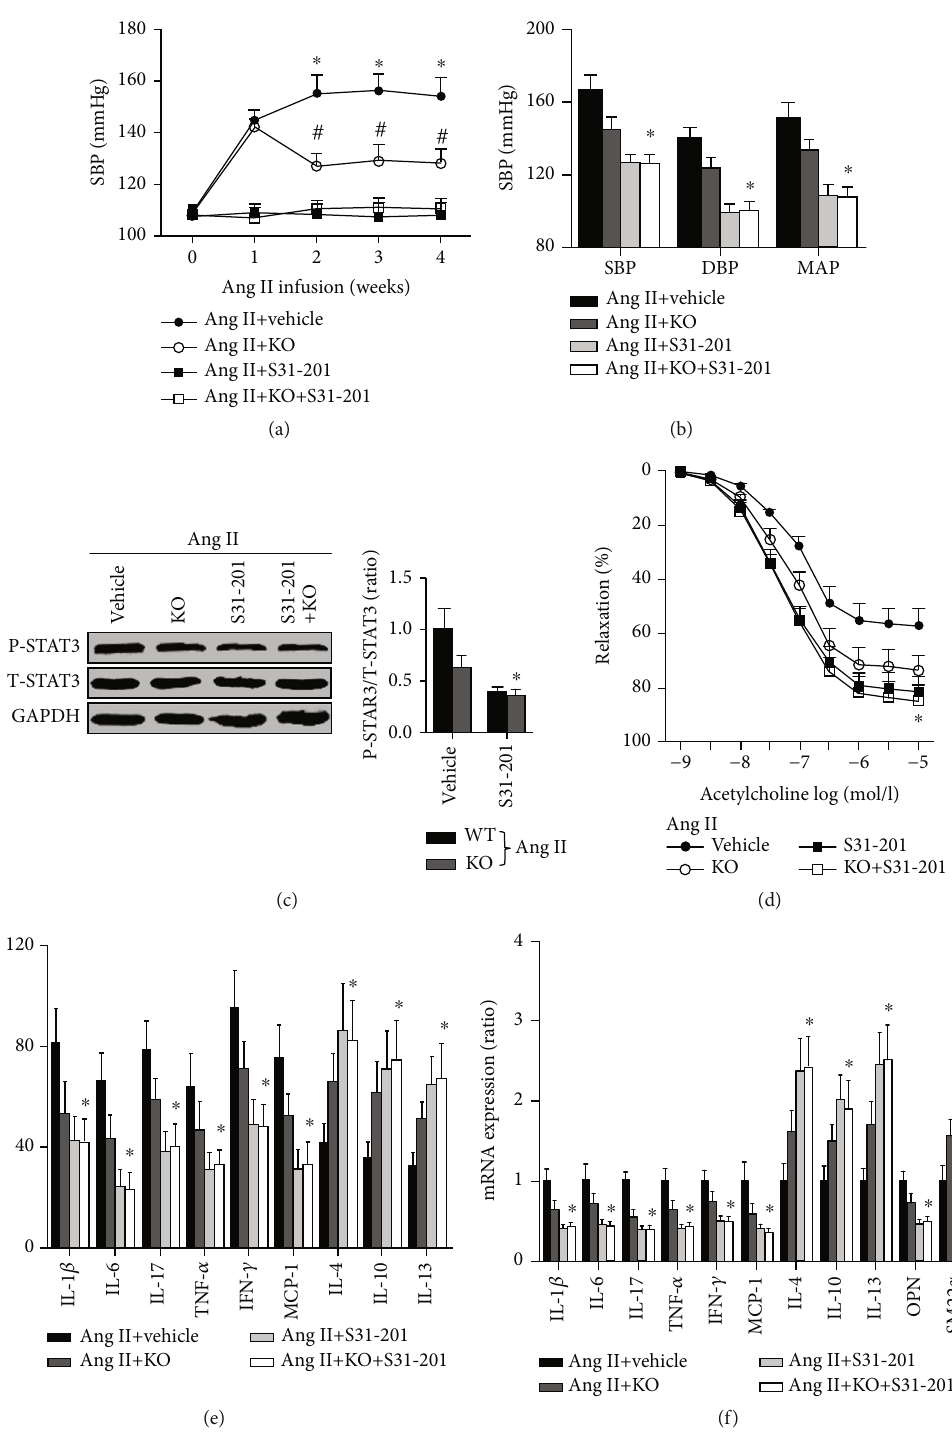
Figure 6: E ff ects of S31-201 on blood pressure, in fl ammation, and phenotypic transformation of smooth muscle. (a, b) Blood pressure was determined using the tail-cu ff method and the Millar Pressure Volume System; N = 10 in each group. (c) The STAT3 phosphorylation in each group was measured. (d) The vascular function for the four groups was detected. (e) Serum cytokine levels were measured using ELISA kits. (f) Aortic mRNA expression of cytokines was analyzed by RT-PCR. N = 5 in each group; ∗ p < 0 : 05 vs. the IL-9-/- Ang II+DMSO